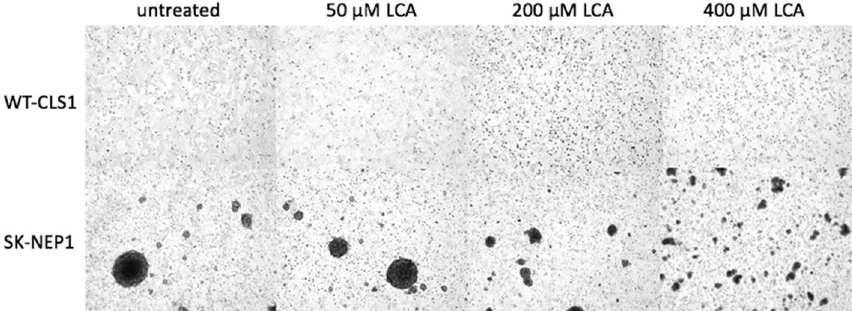
Figure 2. Morphology of the tumor cell-lines WT CLS1 and SK NEP1 and the optical shift due to LCA. WT CLS1 and SK NEP1 were treated with indicated concentrations of LCA for 48 h. Data are representative data of three independent experiments.